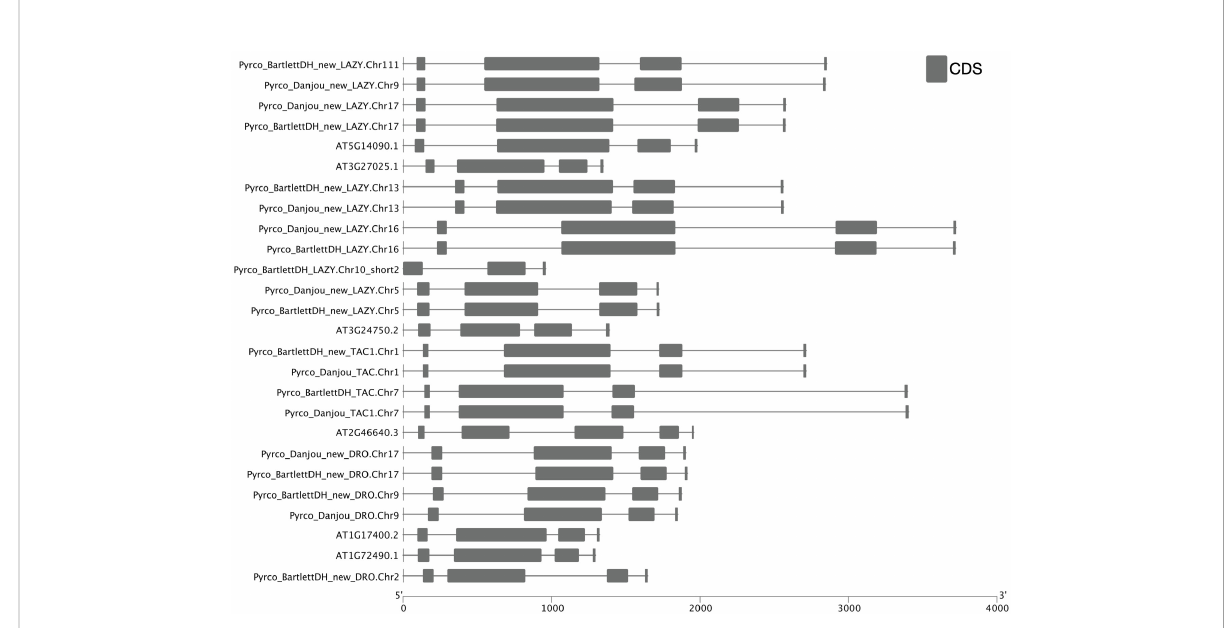
FIGURE 6 Intron-exon structure comparison of IGT genes. Cartoon illustrating intron-exon structures of IGT genes from Arabidopsis thaliana (Araport11), Bartlett.DH_v2, and d ’ Anjou. Boxes indicate exons, lines indicate introns. UTR regions are not shown in this fi